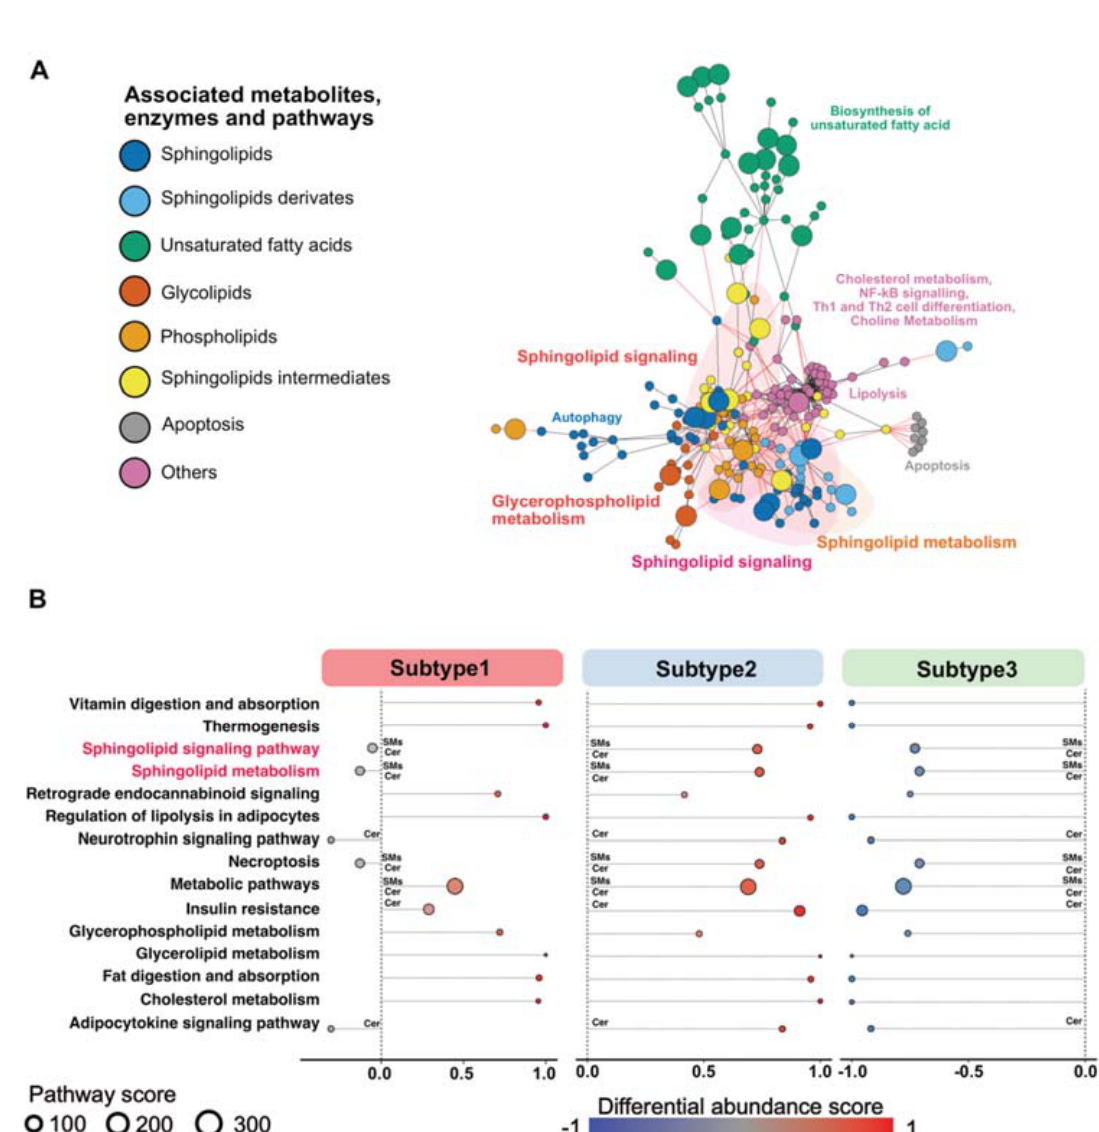
Figure 3. Differential metabolite abundance of complex lipid and fatty acids in metabolic subtypes: ( A ) network analysis depicts significantly enriched metabolites and pathways. Different node colors indicate different network clusters or closely interconnected metabolites. Red lines represent interacting nodes. ( B ) A pathway-based analysis of significant metabolic changes comparing patients assigned to a specific metabolic subtype to the rest of patients. The differential abundance score captures the average gross changes for all metabolites in a pathway. A score of 1 indicates increase in all measured metabolites in the pathway, whereas − 1 indicates decrease in all measured metabolites in a pathway. Pathways associated with sphingomyelins and ceramides are marked with SMs/Cer.